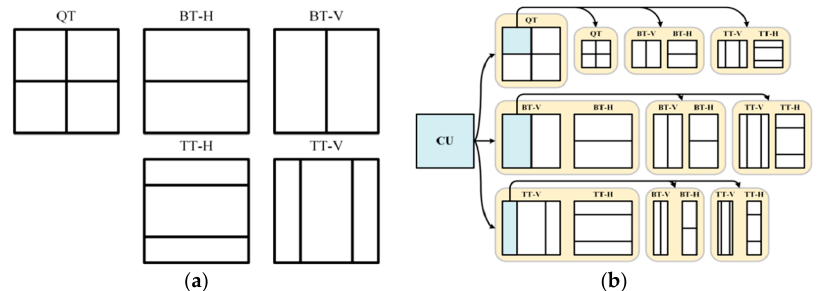
Figure 1. MTT of VVC: ( a ) MTT block partitioning modes; ( b ) Example of recursive block partitioning of MTT.